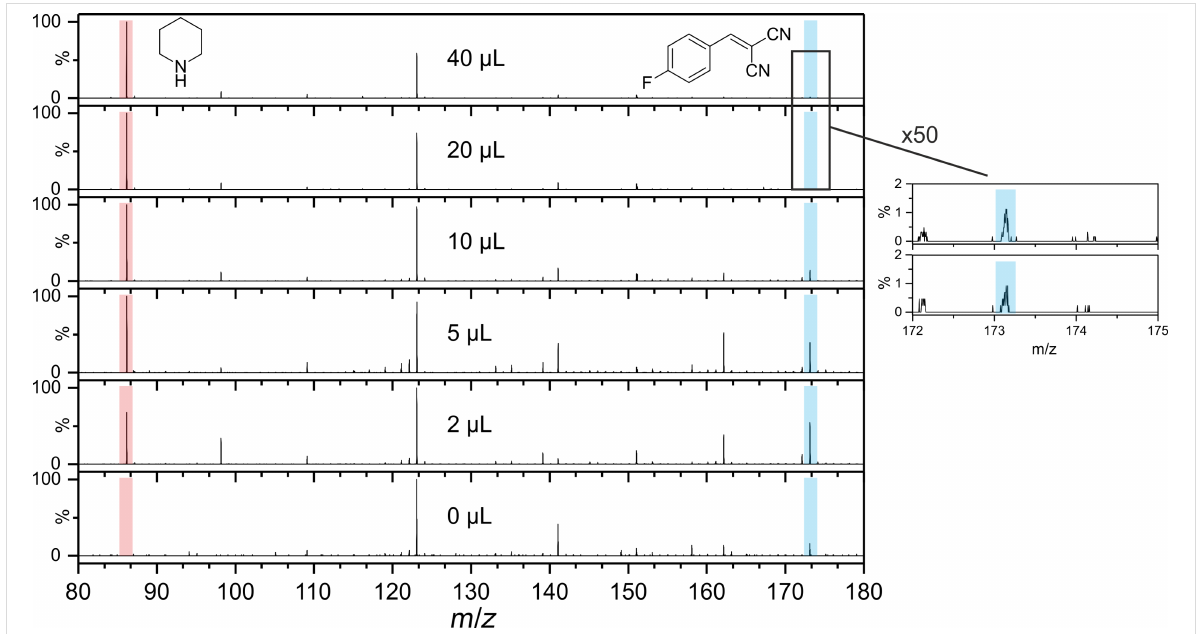
Figure 3: Mass spectra of the different products of 3a . Red: peak off the molecular ion [M + H] + of piperidine ( m / z ≈ 86). Blue: peak of the molecular ion [M + H] + of 3a ( m / z ≈ 173).